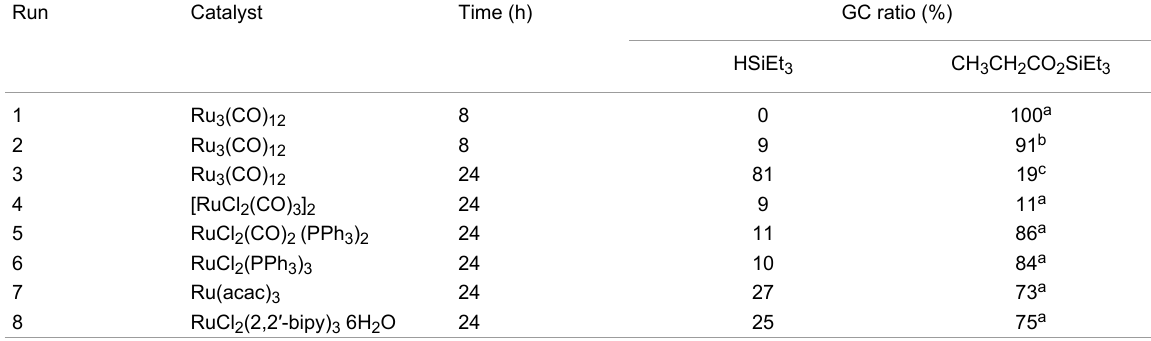
Table 3: Catalyst-screening for the dehydrocoupling of propionic acid with triethylsilane in toluene at 100 °C.